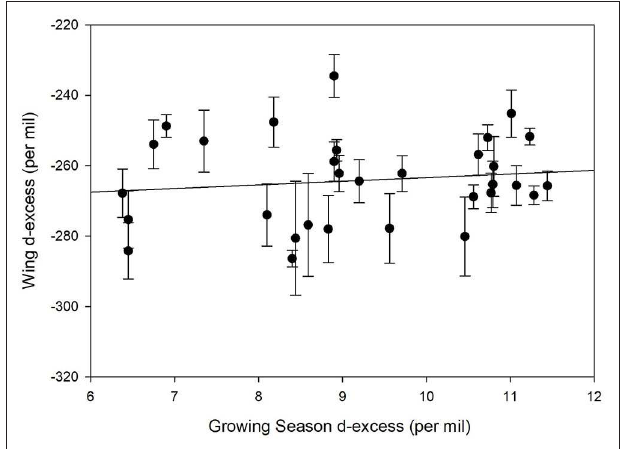
FIGURE 6 | Relationship between measured deuterium excess in known-origin monarch wings ( Table 1 ) and predicted growing season precipitation deuterium excess for these